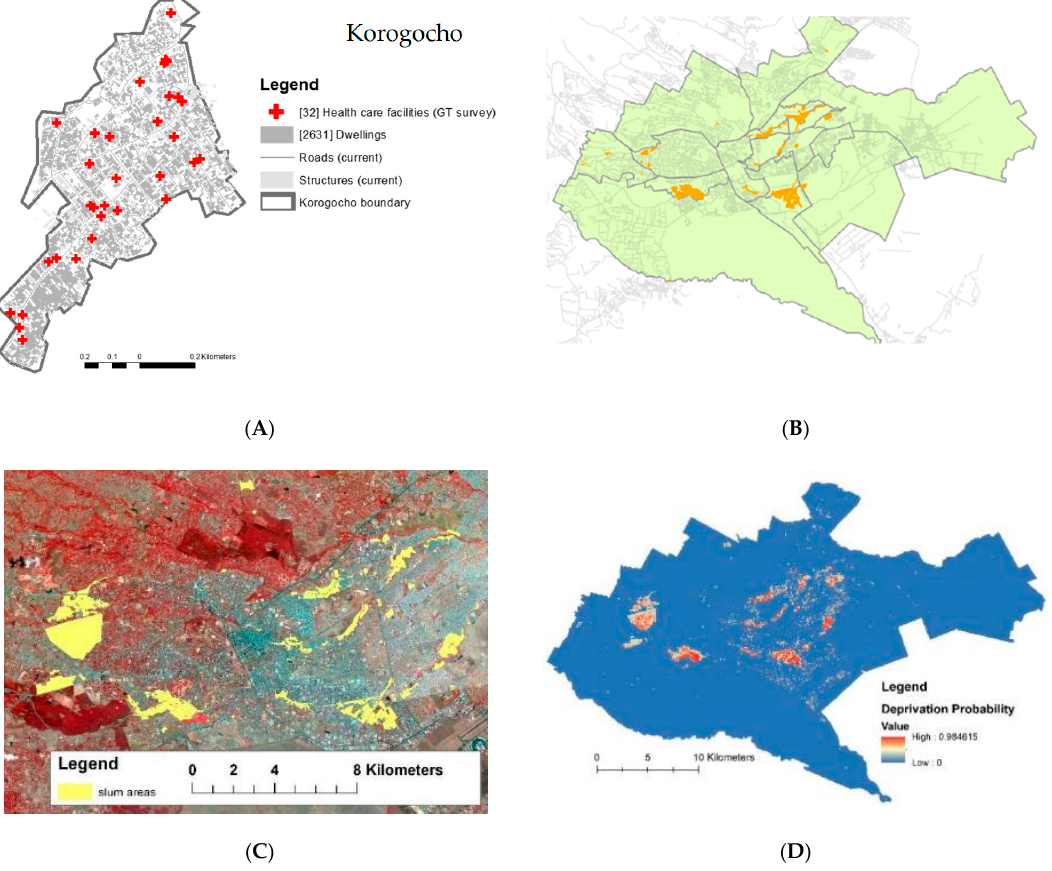
Figure 1. Deprived area maps of Nairobi, Kenya generated with four different approaches to deprived area mapping—( A ) Aggregated deprived households (data source: Improving Health in Slums Collaborative [89]),( B ) field-based mapping (data source: Slum Dwellers International (SDI)), ( C ) human imagery classification (data source: Faculty of Geo-Information Science and Earth Observation (ITC) [90]), and ( D ) machine-learning imagery classification using Sentinel-2 imagery